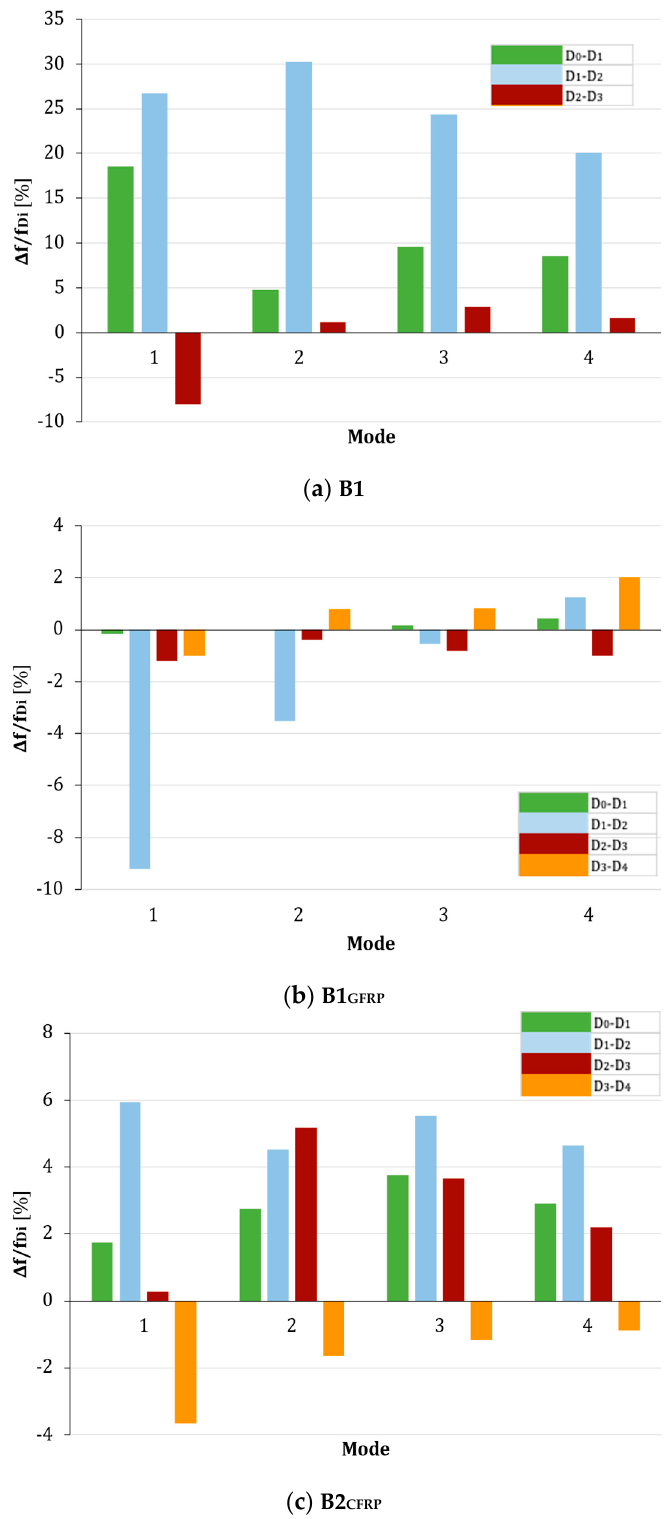
Figure 12. Variation of frequency values at damage D i -1 for each RC beam: ( a ) specimen B1; ( b ) specimen B1 GRP ; and ( c ) specimen B2 CFRP .